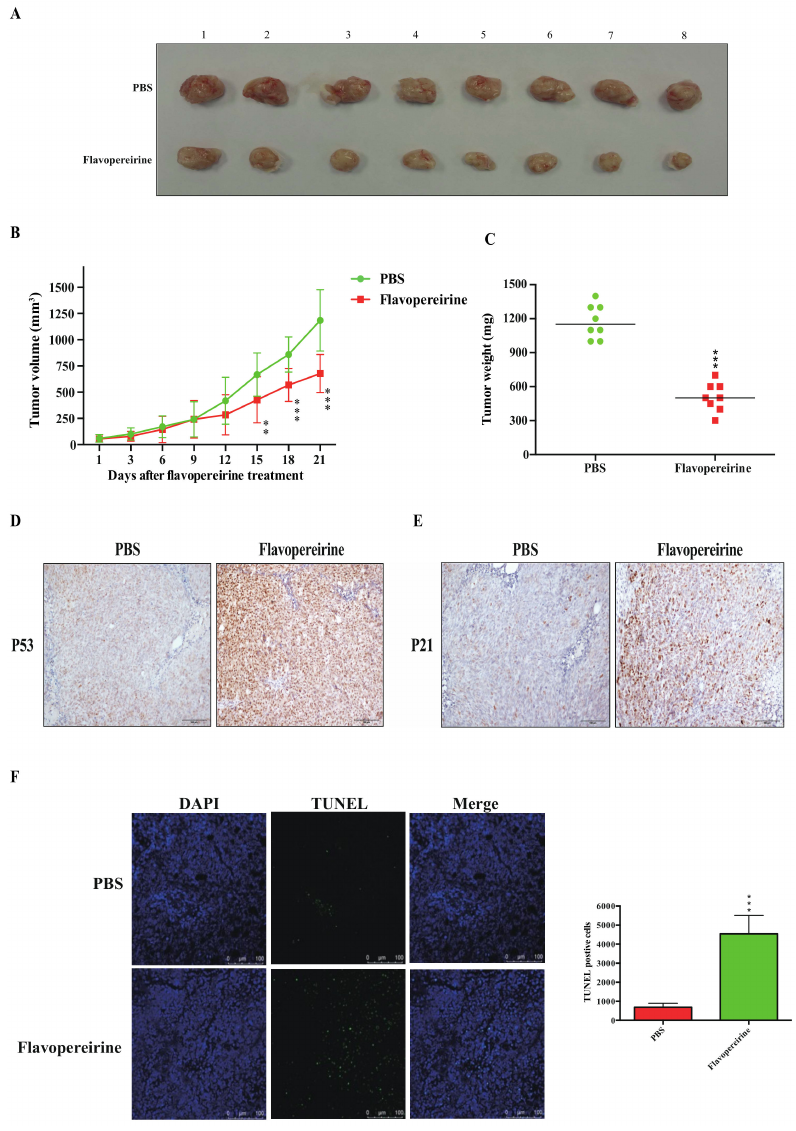
Figure 6. Flavopereirine significantly inhibited in vivo HCT116-xenograft growth. HCT116-bearing mice were treated either with PBS ( n = 8) or flavopereirine (10 mg kg − 1 d − 1 ) ( n = 8). ( A ) Representative images of excised tumors from each group. ( B ) Tumor volumes were measured to reflect tumor growth. ** p < 0.01, *** p < 0.001 compared with PBS. ( C ) Tumor weights were compared on the last day of treatment. *** p < 0.001 compared with PBS. ( D , E ) P53 and P21 expression levels in HCT116 tumors were evaluated by immunohistochemical staining. Scale bar: 100 µ m. ( F ) Apoptosis in HCT116 tumors was measured by TUNEL staining. *** p < 0.001 compared with PBS. Scale bar: 100 µ